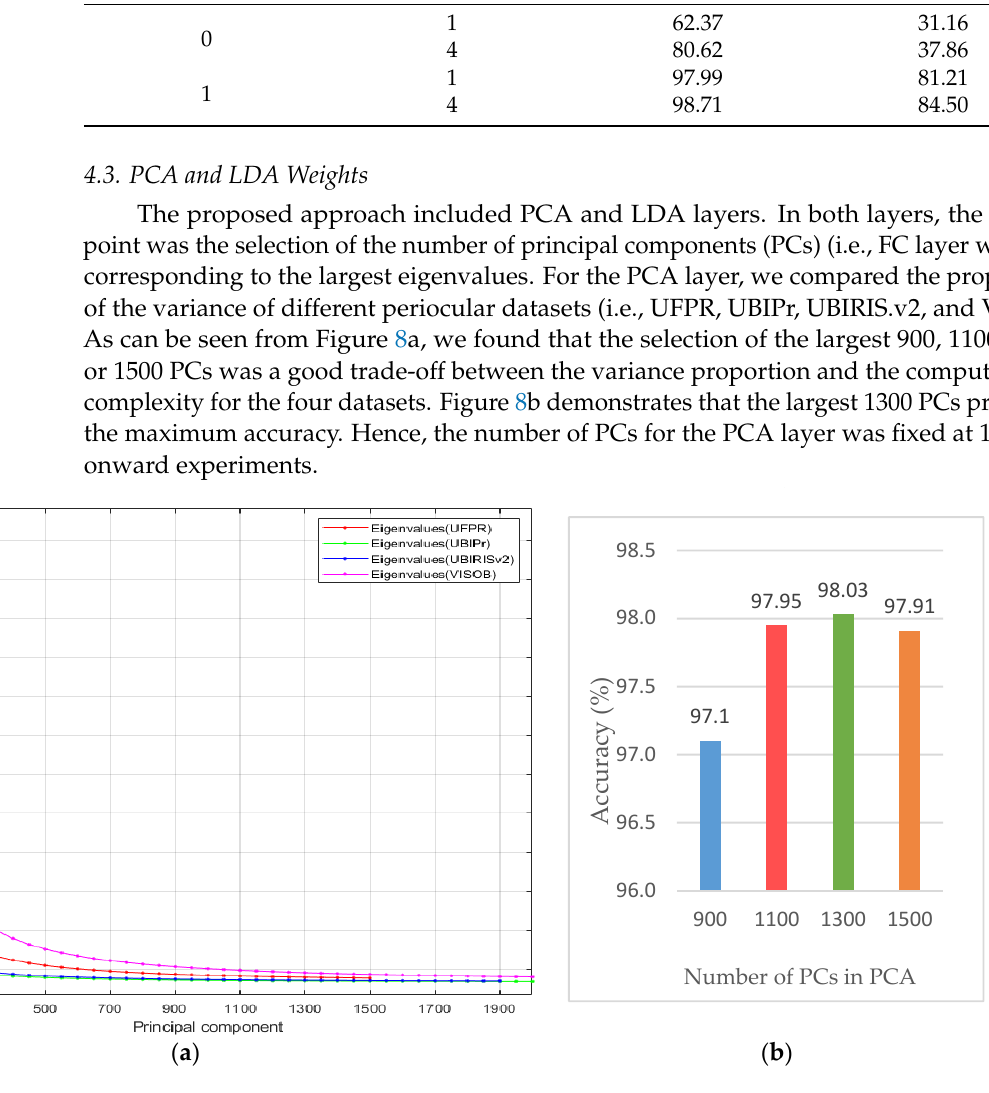
Figure 8. The selection of the number of principal components (PCs): ( a ) The proportion of the variance of the principal components for UFPR, UBIPr, UBIRIS.v2 and VISOB datasets; ( b ) The performance of LDA-CNN model with different number of PCs using fold 1 UFPR dataset.